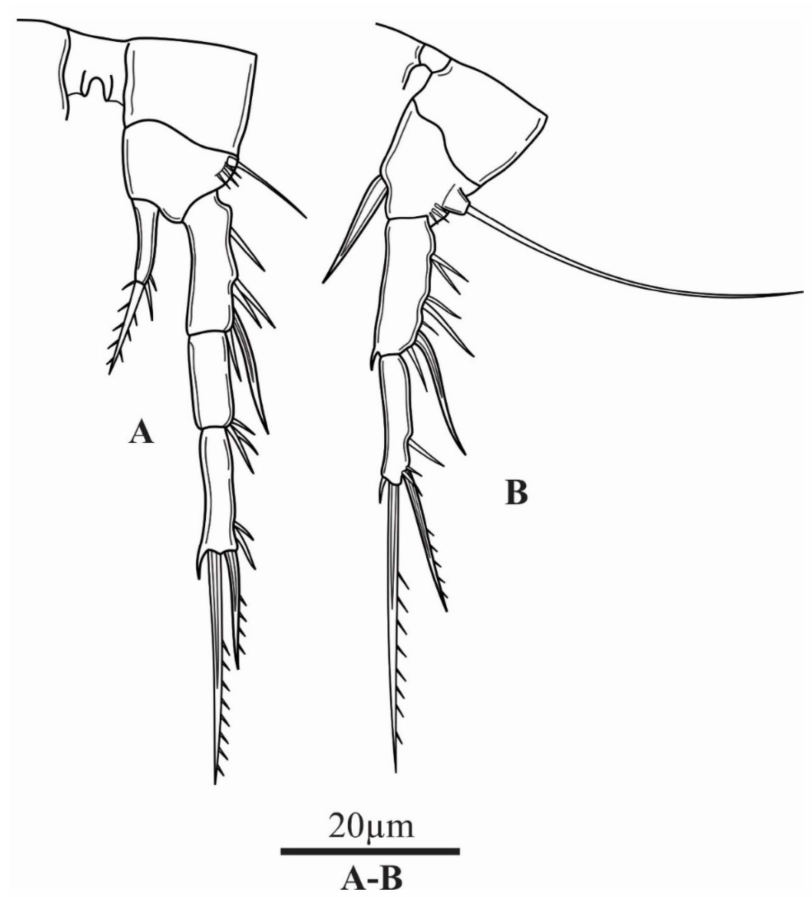
Figure 6. Parastenocaris sontraensis sp. nov. holotype female. ( A ), P3; ( B ), P4. Antennule (Figure 8A) 7-segmented; aesthetascs on fifth and seventh segment, long, with rounded tips. Geniculation between third and fourth and between fifth and sixth segments. All setae slender and smooth. Setal formula: 0.4.3.0.1 + ae.0.9 + ae. P3 (Figure 8B,C) basis rhomboidal, with five robust spinules on posterior surface; one long smooth outer seta. Enp reduced to one smooth seta (indicated with arrow). Exp 3-segmented, robust, curved inward. Exp-1 about 3.4 times as long as wide, with small spinule on outer distal corner; thin hyaline lamella along inner margin. Exp-2 very short, with long outer apophysis, slightly curved inward, smooth. Exp-3 as long as apophysis, with sharp tip, smooth. P4 (Figure 9A) basis with two finger-like inner outgrowths (indicated with arrows); one straight, smooth and parallel to Enp; the second one curved, pointing outwards; with outer smooth seta. Exp 3-segmented, Enp 1-segmented. Enp blade-like, slightly shorter than Exp-1, with thin, smooth seta sub-apically. Exp with few large spinules on distal margin of all segments. Exp-1 with concave inner margin, with long spines along outer margin. Exp-2 without spine or seta. Exp-3 with one unilaterally pinnate spine sub-apically and one unilaterally pinnate spiniform seta, about 1.5 times as long as supporting